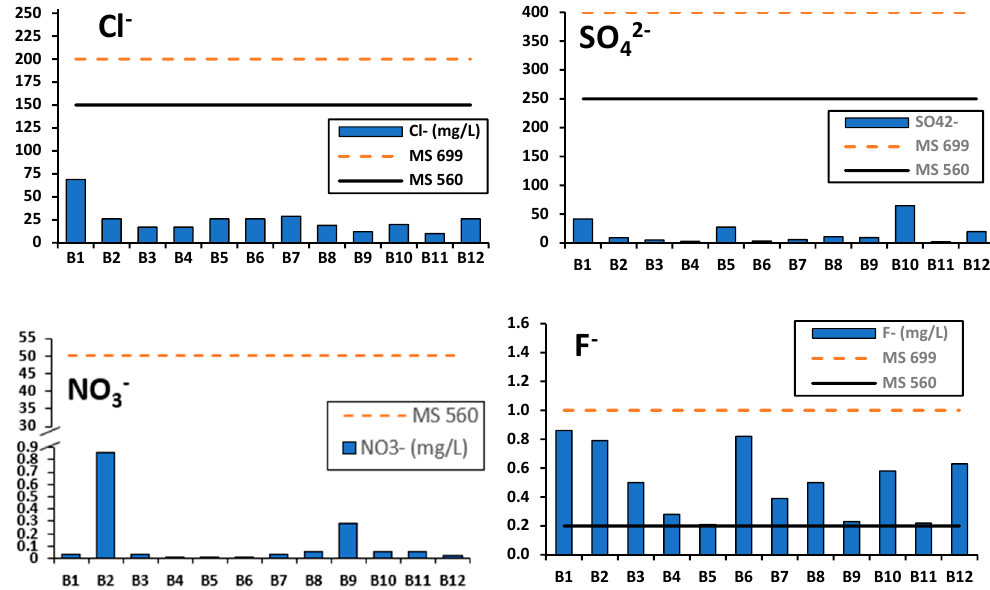
Figure 3. Variations in major anions (Cl − , SO 4 2 − , NO 3 − , and F − ) in mg/L compared to MS 699 (bottled water) and MS 560 (natural mineral water) standards. Data for each brand is the mean values of the total samples ( n = 30).